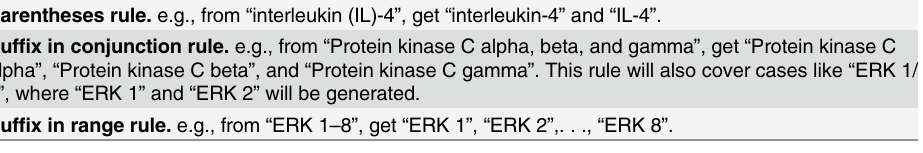
Table 3. Rules for generating multiple candidates from a sequence of tokens. Parentheses rule. e.g., from “ interleukin (IL)-4 ” , get “ interleukin-4 ” and “ IL-4 ” . Suf fi x in conjunction rule. e.g., from “ Protein kinase C alpha, beta, and gamma ” , get “ Protein kinase C alpha ” , “ Protein kinase C beta ” , and “ Protein kinase C gamma ” . This rule will also cover cases like “ ERK 1/ 2 ” , where “ ERK 1 ” and “ ERK 2 ” will be